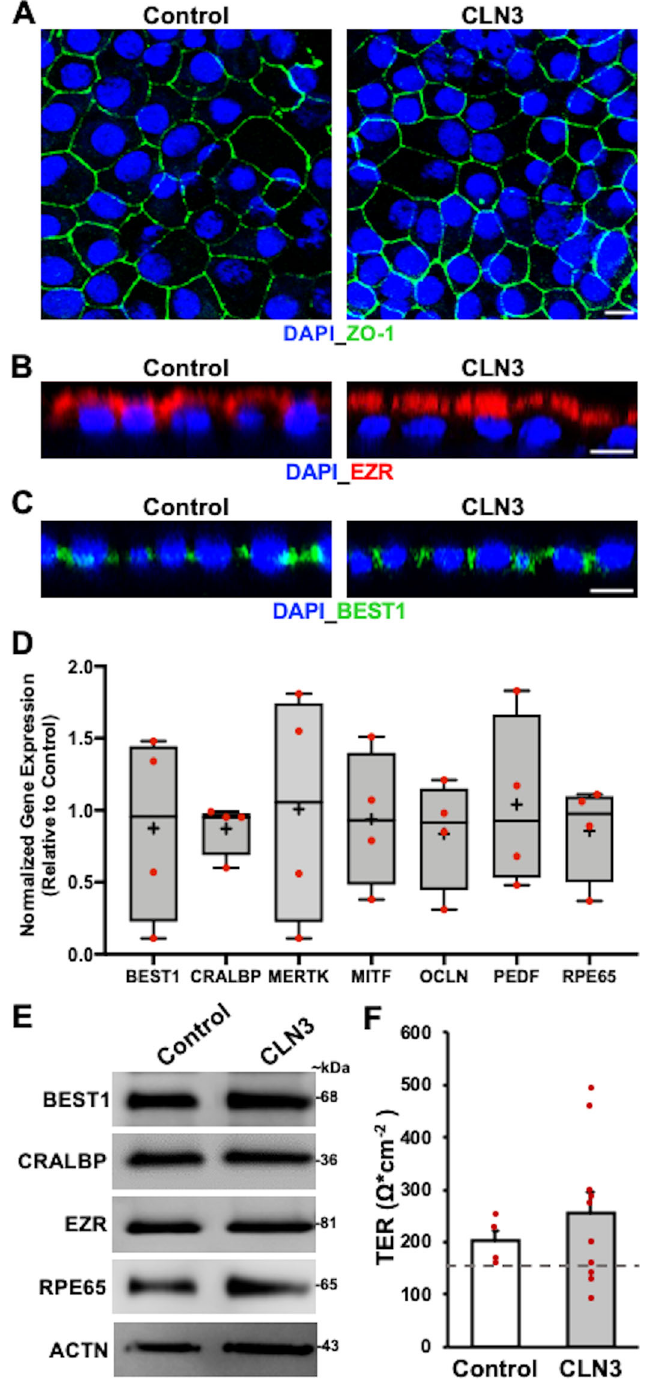
RPE, the amount of auto fl uorescence was decreased in CLN3 disease hiPSC-RPE cells compared to parallel cultures of control hiPSC-RPE cells (Fig. 2D – H). Note that control and CLN3 disease hiPSC-RPE display similar localization of tight junction marker, ZO-1 (Fig. 2D). In contrast, the amount of auto fl uor- escence was decreased in CLN3 disease hiPSC-RPE cells (Fig. 2D – H ) . Furthermore, orthogonal view of hiPSC-RPE sections con fi rmed that auto fl uorescence accumulation post- chronic POS feeding was within the control and CLN3 disease hiPSC-RPE cells (Fig. 2F). Of note, parallel cultures of